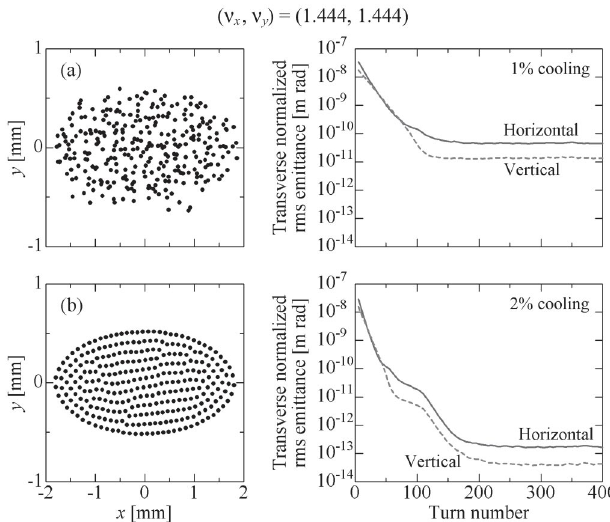
FIG. 3. MD results of two ion beams cooled with a linear frictional force. The 3D cooling force has been slightly strength- ened in the lower pictures, compared to the upper case. The lattice parameters are the same as those assumed in Fig. 1. The beam is continuous and the line density is 2 : 5 (cid:9) 10 6 m (cid:1) 1